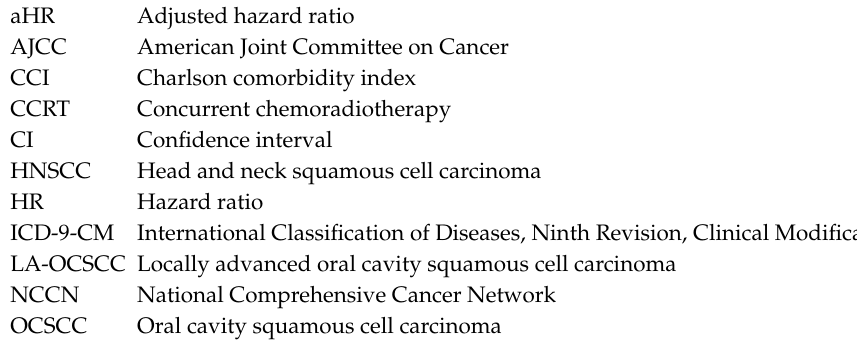
Figure S3: Cox proportional hazards model curves for overall survival of elderly patients ( ≥ 70 years) with